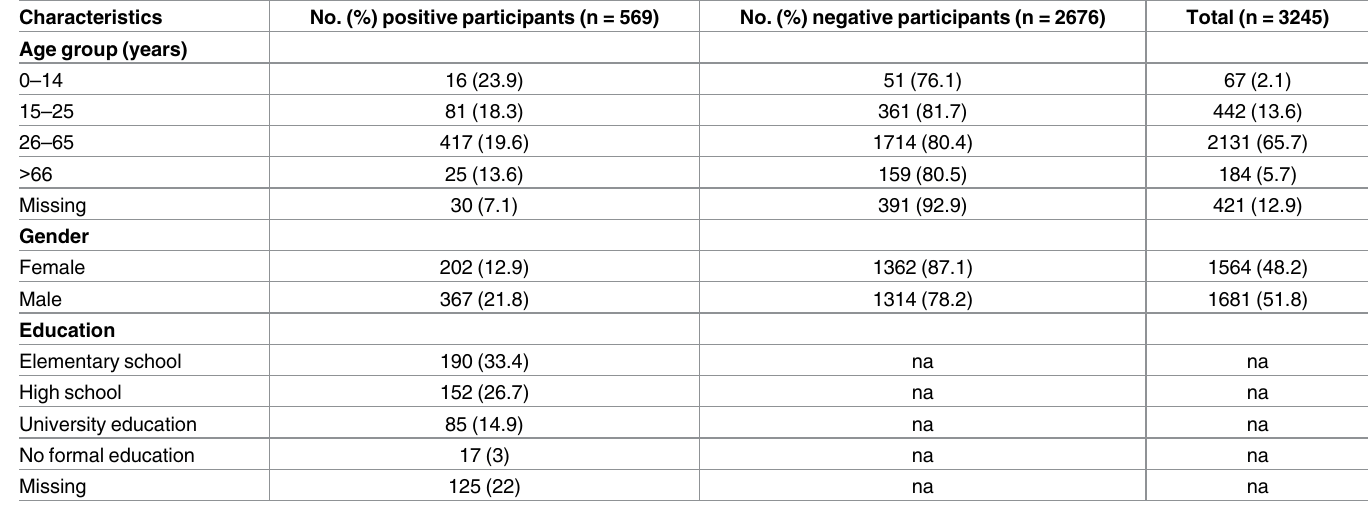
Table 3. Characteristics of positive and negative participants to intestinal parasites.